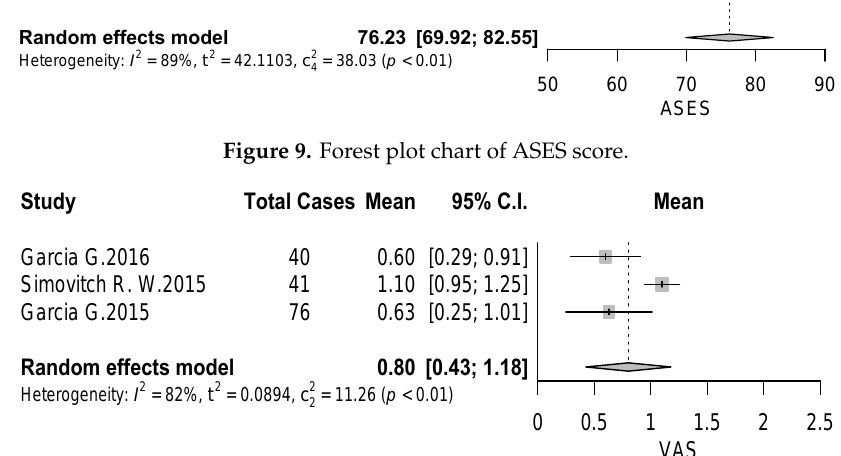
Figure 10. Forest plot chart of VAS score.